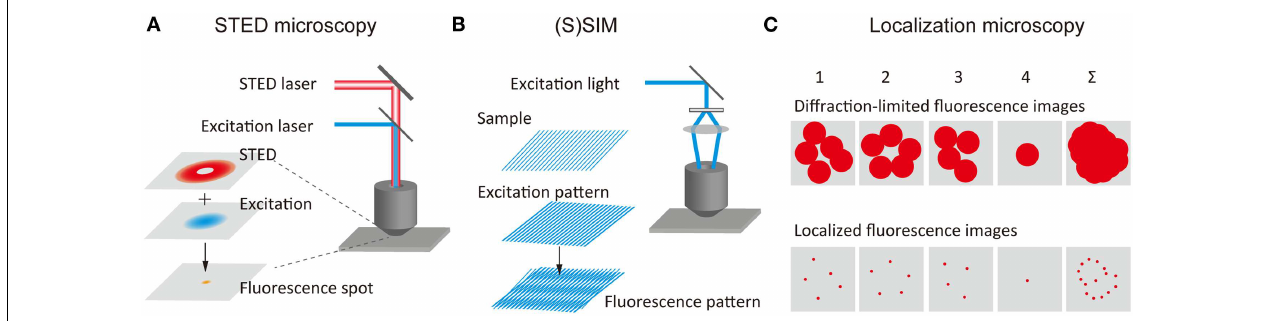
FIGURE 1 | Principles of super-resolution fluorescence structural imaging. Schematic illustrations of the principles of (A) STED microscopy, (B) (S)SIM, and (C) localization microscopy.